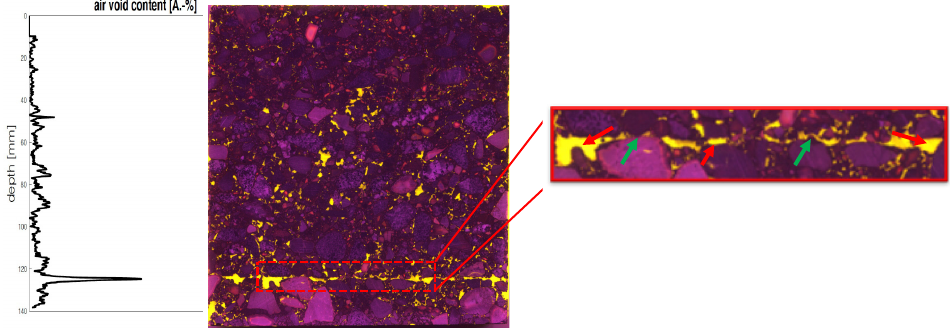
Figure 6. Analysis of voids over depth using asphalt petrology (red arrows: void analysis; green arrows: location of aggregate).